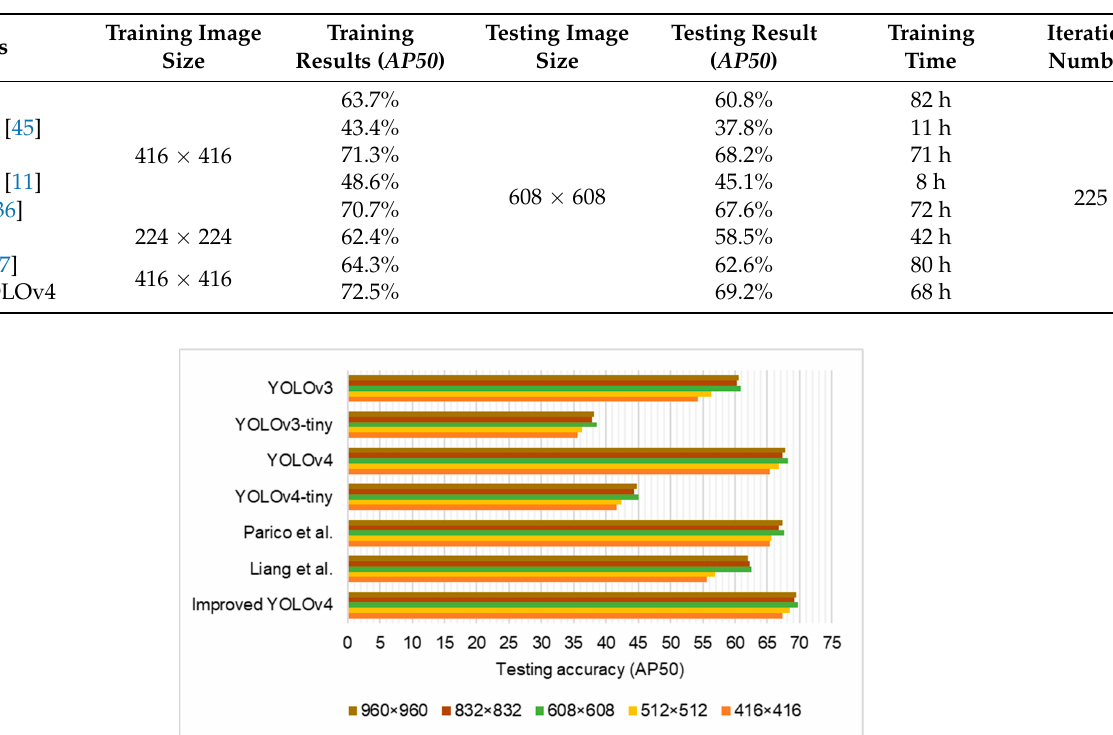
Table 5. Comparison of fruit and vegetable classification models training precision with original fruit and vegetable images.